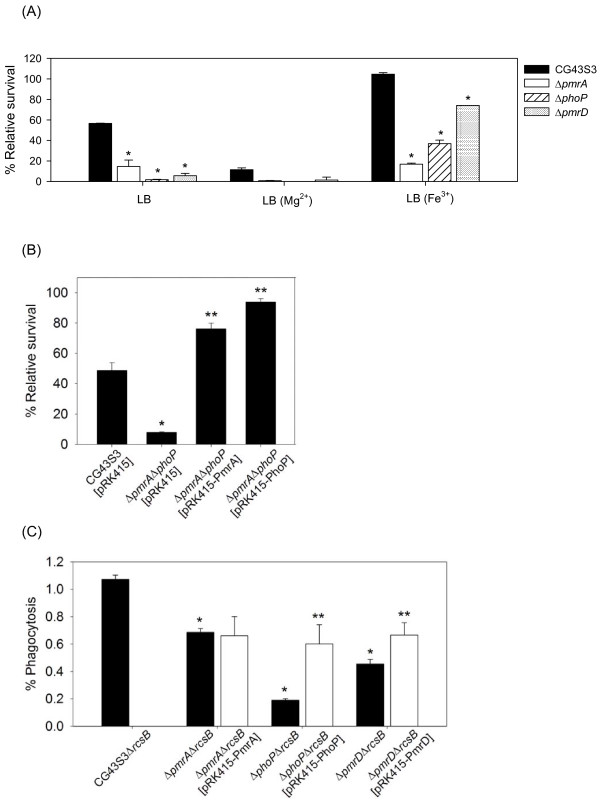
Effects of K. pneumoniae pmrA, pmrD and phoP deletion and complementation in polymyxin B resistance and intramacrophage survival. (A) The log-phased cultures of K. pneumoniae CG43S3, the ΔpmrA, ΔpmrD or ΔphoP mutants were grown in LB, LB supplemented with 10 mM Mg2+ or LB supplemented with 1 mM Fe3+ and then challenged with 2 units/ml of polymyxin B. The survival rates are shown as the average ± standard deviations from triplicate samples. (B) The log-phased cultures of K. pneumoniae CG43S3 carrying pRK415, the ΔpmrAΔphoP mutant strains carrying pRK415, pRK415-PhoP or pRK415-PmrA were grown in LB and challenged with 2 units/ml of polymyxin B. The survival rates are shown as the average ± standard deviations from triplicate samples. (C) The survival rates of K. pneumoniae CG43S3ΔrcsB, the isogenic ΔpmrAΔrcsB, ΔphoPΔrcsB and ΔpmrDΔrcsB mutants, and each mutant strain carrying the complementation plasmids pRK415-PmrA, pRK415-PhoP or pRK415-PmrD within the mouse macrophage RAW264.7 were determined. The results shown are relative survival rates which were calculated from the viable colony counts of intracellular bacteria divided by individual original inoculums. Values are shown as the average of five replicas. Error bars, standard deviations. *, P < 0.01 compared to each parental strain; **, P < 0.01 compared to each mutant strain carrying the complementation plasmid.